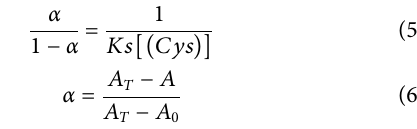
Frontiers in Chemistry |